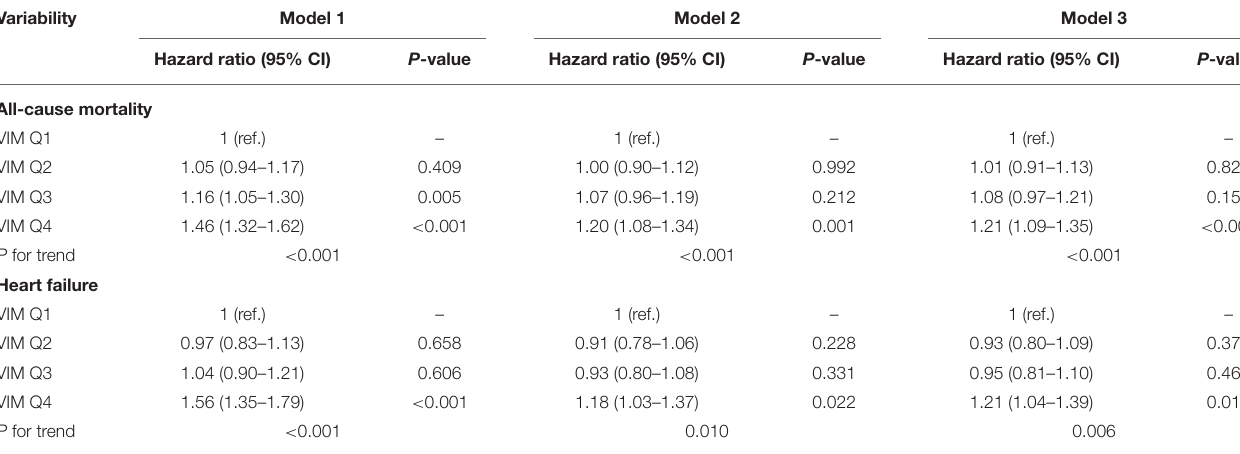
Model1:adjustedforage,sex,raceatvisit4;Model2:adjustedforModel1 + educationlevel,BMI,smokingstatus,drinkingstatus,totalcholesterol,HDL-C,LDL-C,triglyceride,fasting glucose, eGFR, prevalent hypertension, diabetes mellitus, coronary heart disease, myocardial infarction, stroke, antihypertensive medicine, aspirin, statin at visit 4; Model 3: adjusted for Model 2 + SBP, DBP at visit 4 and mean of MAP from visit 1 to 4. MAP, mean arterial pressure; VIM, variability independent of the mean; BMI, body mass index; HDL-C, high-density lipoprotein cholesterol; LDL-C, low-density lipoprotein cholesterol; eGFR, estimated glomerular filtration rate; SBP, systolic blood pressure; DBP, diastolic blood pressure.